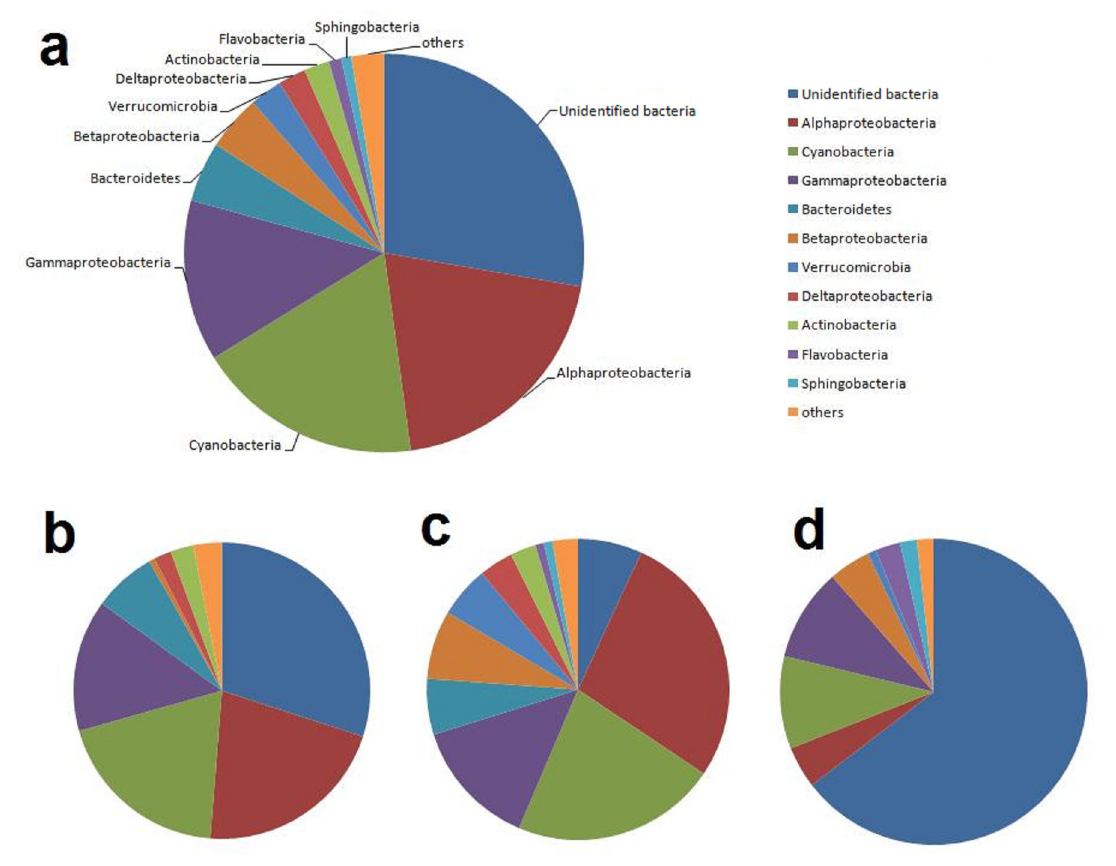
Figure 3. Pie charts of the relative abundance of the bacterial 16S rRNA gene clusters a, all the sequenced clones; b, water samples collected in spring; c, water samples collected in summer; d, water samples collected in winter. doi: